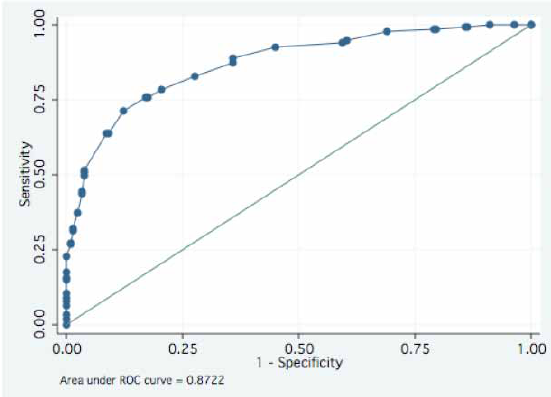
Figure 1. ROC Curve for